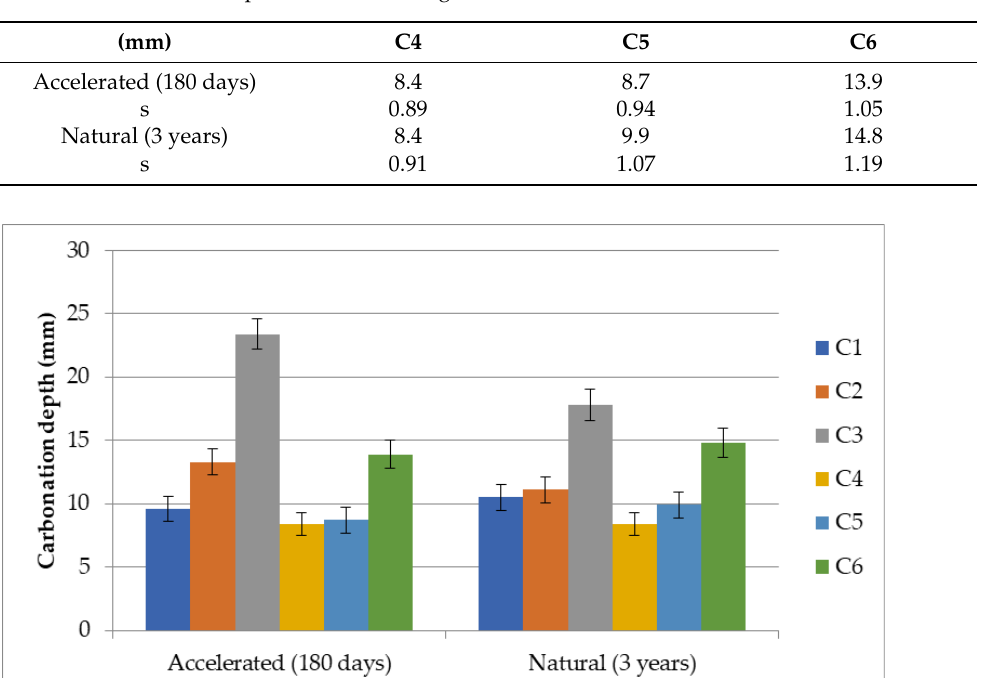
Table 15. Carbonation depth of C30/37 strength class mixtures.